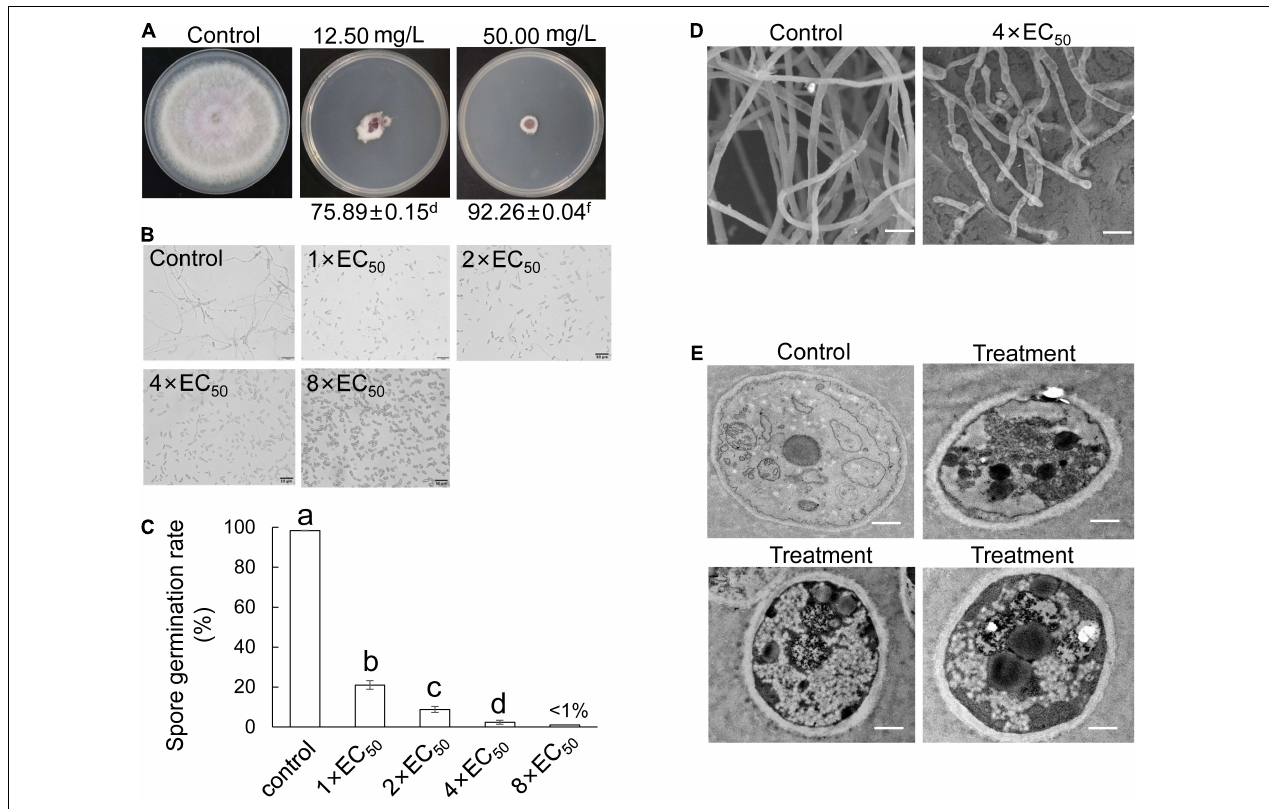
FIGURE 6 | Antifungal mechanism of S. malaysiensis 8ZJF-21 extract on Foc TR4 in vitro . (A) Inhibition ability assay of different dose extracts on the hyphal growth of Foc TR4. (B) Inhibition efficiency of different dose extracts on spore germination of Foc TR4. Bar = 10 µ m. (C) Quantitative analysis of spore germination of Foc TR4 after treatment with different dose extracts. Different letters indicate a significant difference according to Duncan’s multiple range test ( P < 0.05). (D) Characteristics of hyphal morphology of Foc TR4 after treatment with 4 × EC 50 extract. Bar = 1 µ m. (E) Ultrastructural characteristics of Foc TR4 after treatment with 4 × EC 50 extract. Bar = 0.5 µ